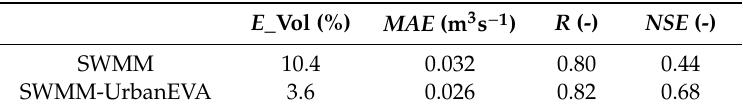
Figure 7. Simulated stream flow with SWMM and SWMM-UrbanEVA and observed flow at the measurement station AB. Table 6. Model performance based on error measures and performance criteria related to the total flow rate in the period 21 January 2016 to 31 July